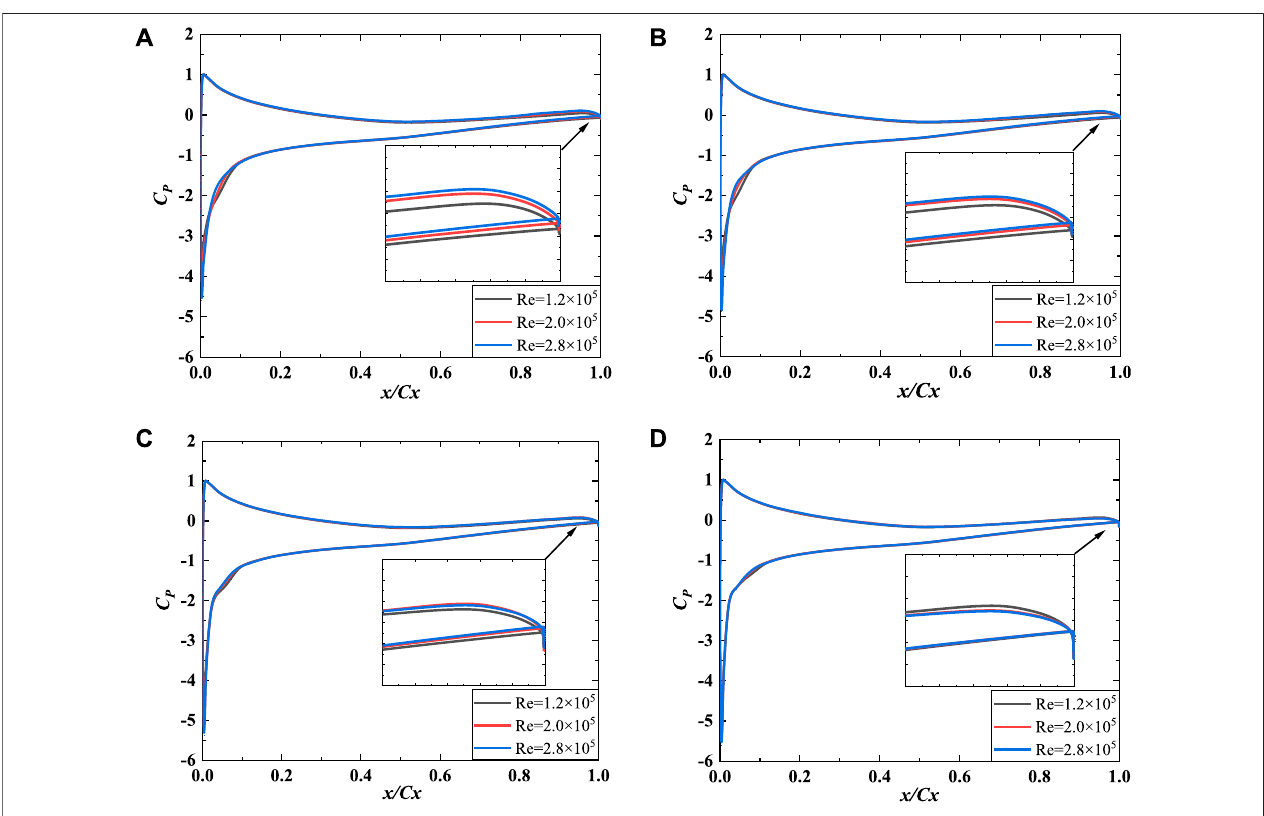
FIGURE 11 | Effect of roughness on surface static pressure distribution at different Reynolds numbers: (A) smooth, (B) 19 μ m, (C) 74 μ m, and (D) 180 μ m.